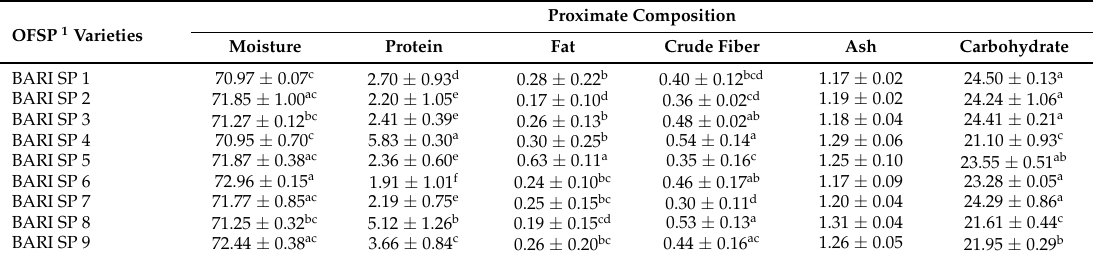
Table 2. Proximate composition (g/100 g of sample) of nine varieties of orange-fleshed sweet potato with peel. Proximate Composition OFSP 1 Varieties Moisture Protein Fat Crude Fiber